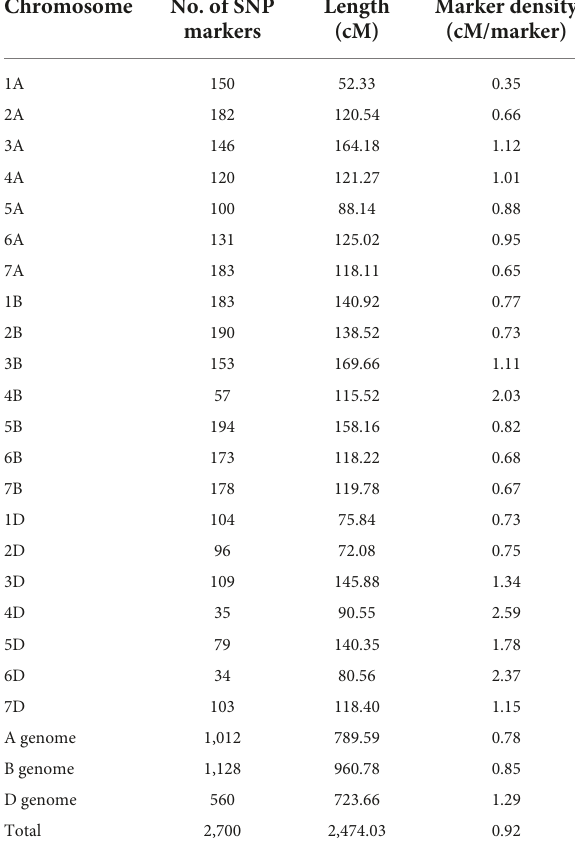
TABLE 3 Summary of linkage groups and marker statistics obtained from a 90K SNP array analysis of the Jinchun 7 × Jinmai 919 DH